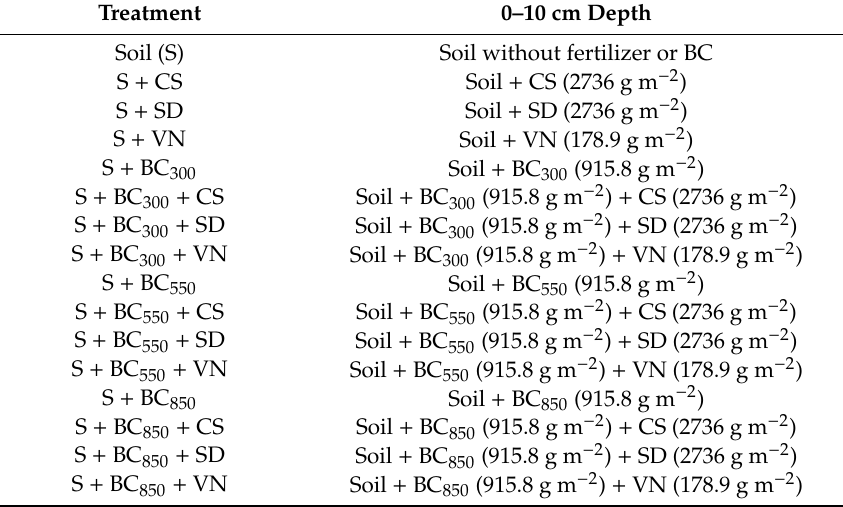
Table 1. Mixture for the 0–10 cm depth layer for each of the treatments and amount of applied biochar and / or fertilizer (g m − 2 ). BC300: torrefied granules at 300 ◦ C, BC550: BC300 pyrolyzed at 550 ◦ C, BC850: BC300 pyrolyzed at 850 ◦ C, CS: cattle slurry, SD: slurry digestate, VN: